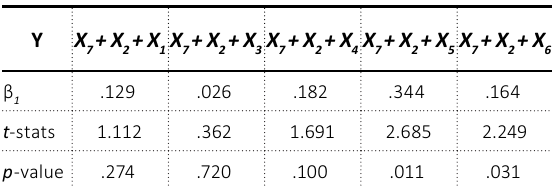
Table 3. Summary of results based on step 3: